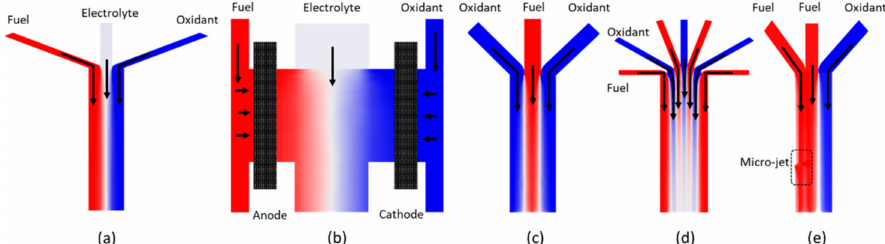
Figure 4. CLFMMFCs with multi-stream configurations: ( a ) multi-stream MMFC with an extra electrolytic stream, ( b ) multi-stream MMFC with extra electrolytic stream and flow-through type electrodes (indicated by black color), ( c ) multi-stream MMFC with oxidant-fuel-oxidant configuration, ( d ) multi-stream MMFC with multiple fuel and oxidant streams, and ( e ) multi-stream MMFC with an immersed micro-fuel